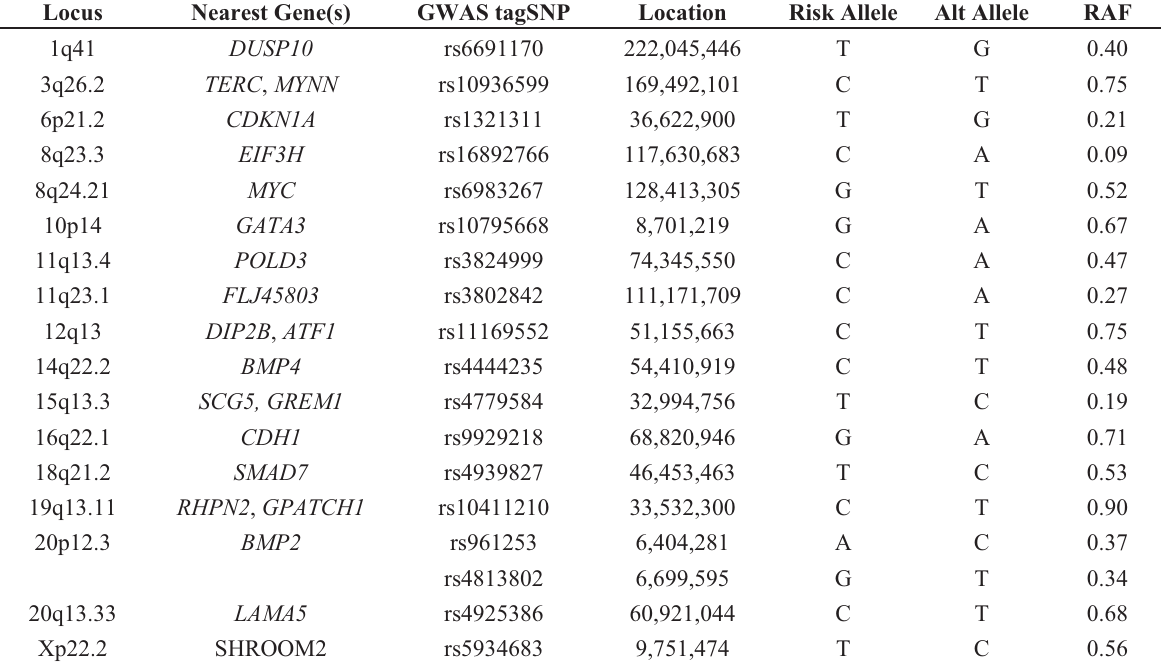
Table 2. Loci identified as associated with colorectal cancer through genome-wide association studies and